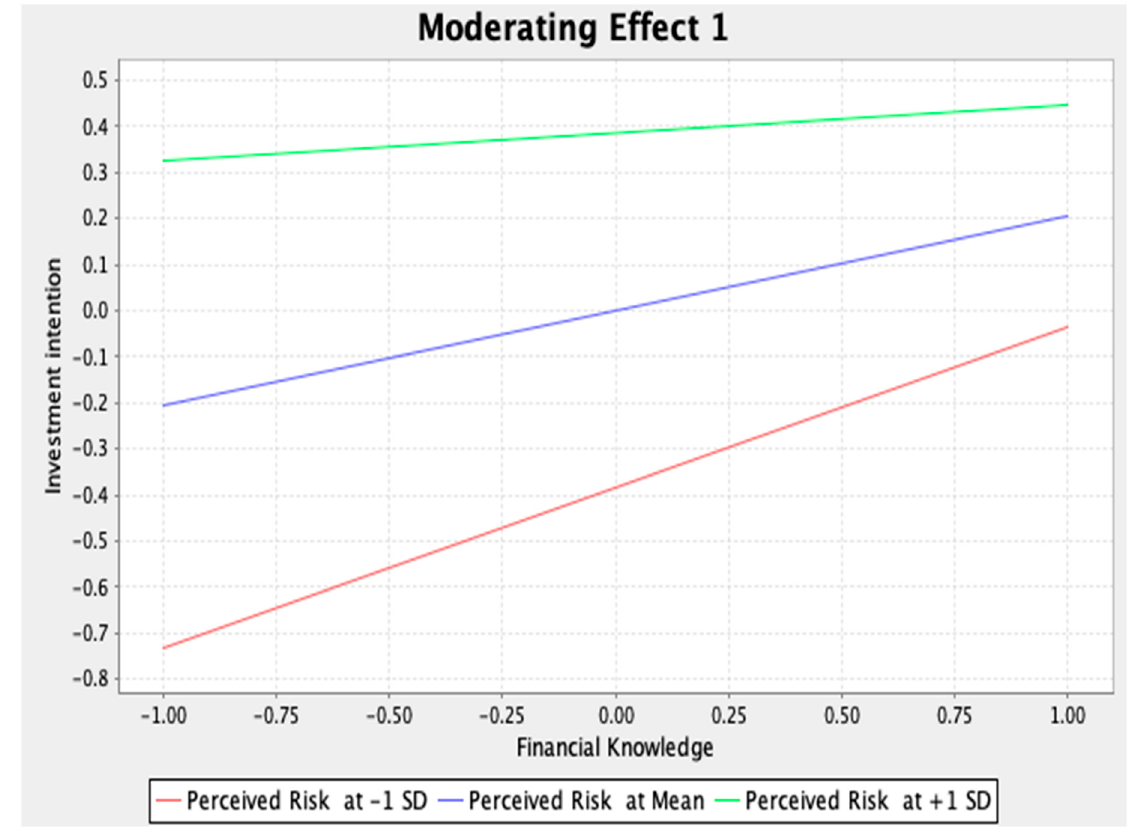
Figure 3. Moderating effect. Source: Outputs of statistical analysis using Smart PLS software.